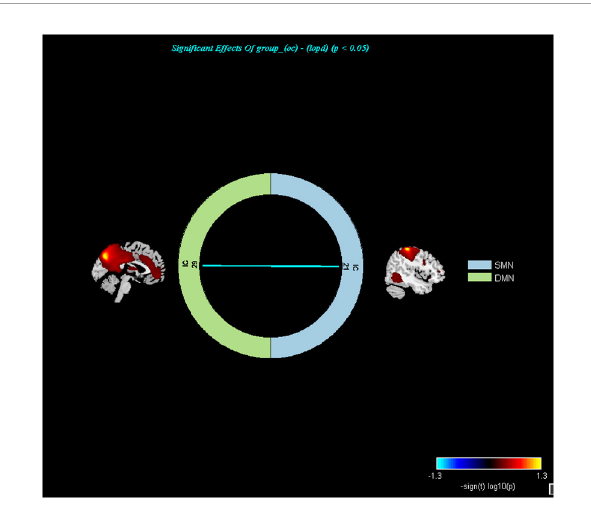
FIGURE5 Networks with altered inter-network functional connectivity between LOPD and OCs ( P < 0.05, FDR corrected). Color represents functional connection strength. The cooler the color, the weaker the functional connection. SMN, sensorimotor network; DMN, default mode network.